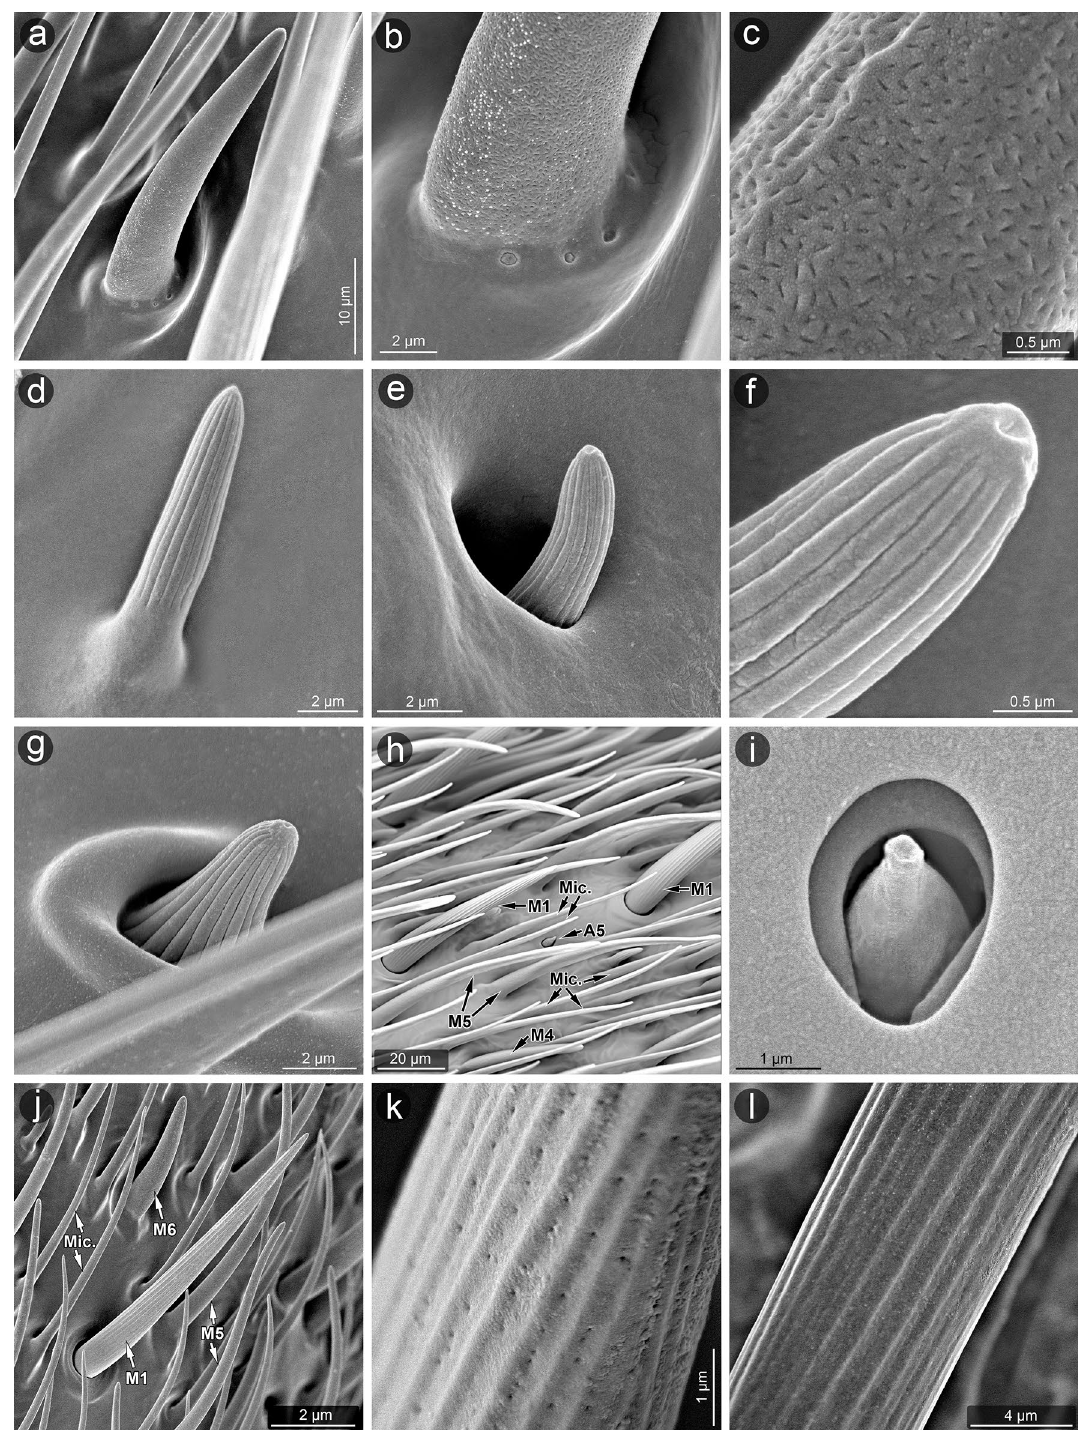
Figure 6. Micromorphology of selected types of sensilla ( L. occidentalis ) analyzed in SEM. Type M6 ( a – c ); M7 ( d ); M8 ( e , f ); M9 ( g ); A5 ( h , i ); M1 ( j , k ); A3 ( l ). Abbreviations are given in the